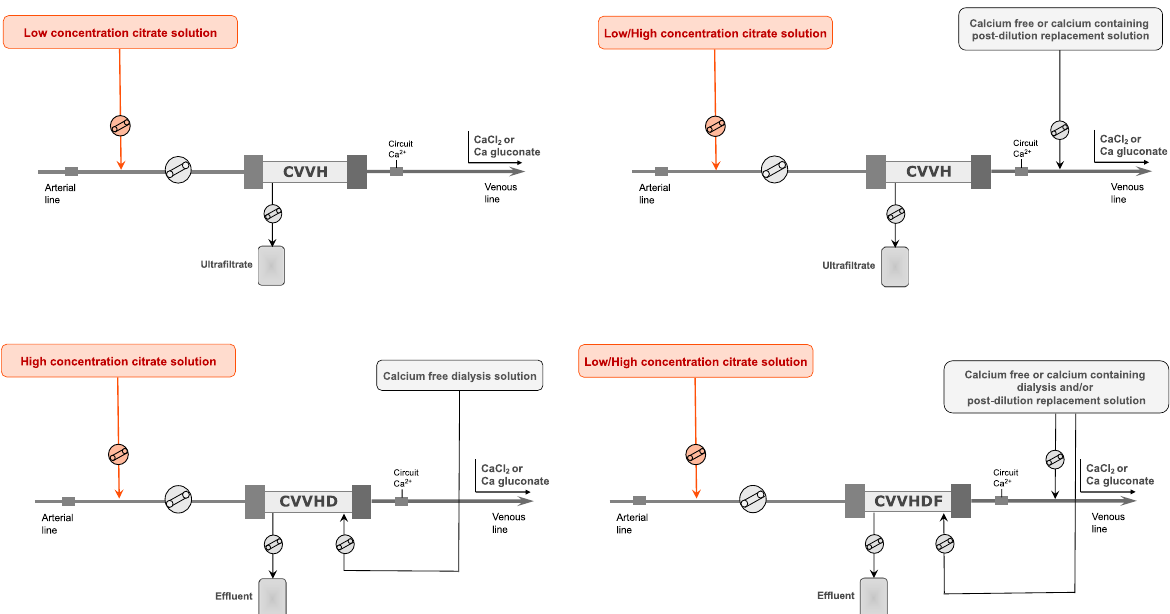
Fig. 1 Simplified CRRT circuits with RCA for CVVH, CVVHD, and CVVHDF. Abbreviations: CRRT, continuous renal replacement therapy; RCA, regional citrate anticoagulation; CVVH, continuous venovenous hemofiltration; CVVHD, continuous venovenous hemodialysis; CVVHDF, continuous venovenous hemodiafiltration; Qb, blood flow